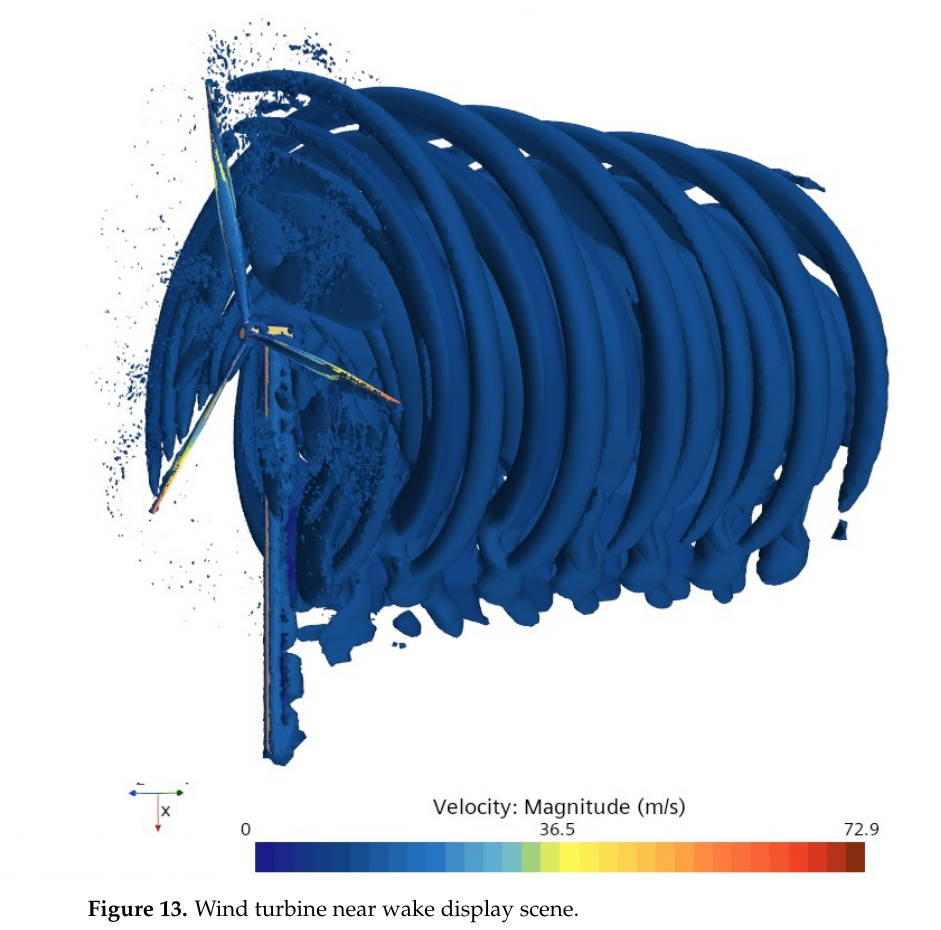
Figure 13. Wind turbine near wake display scene.